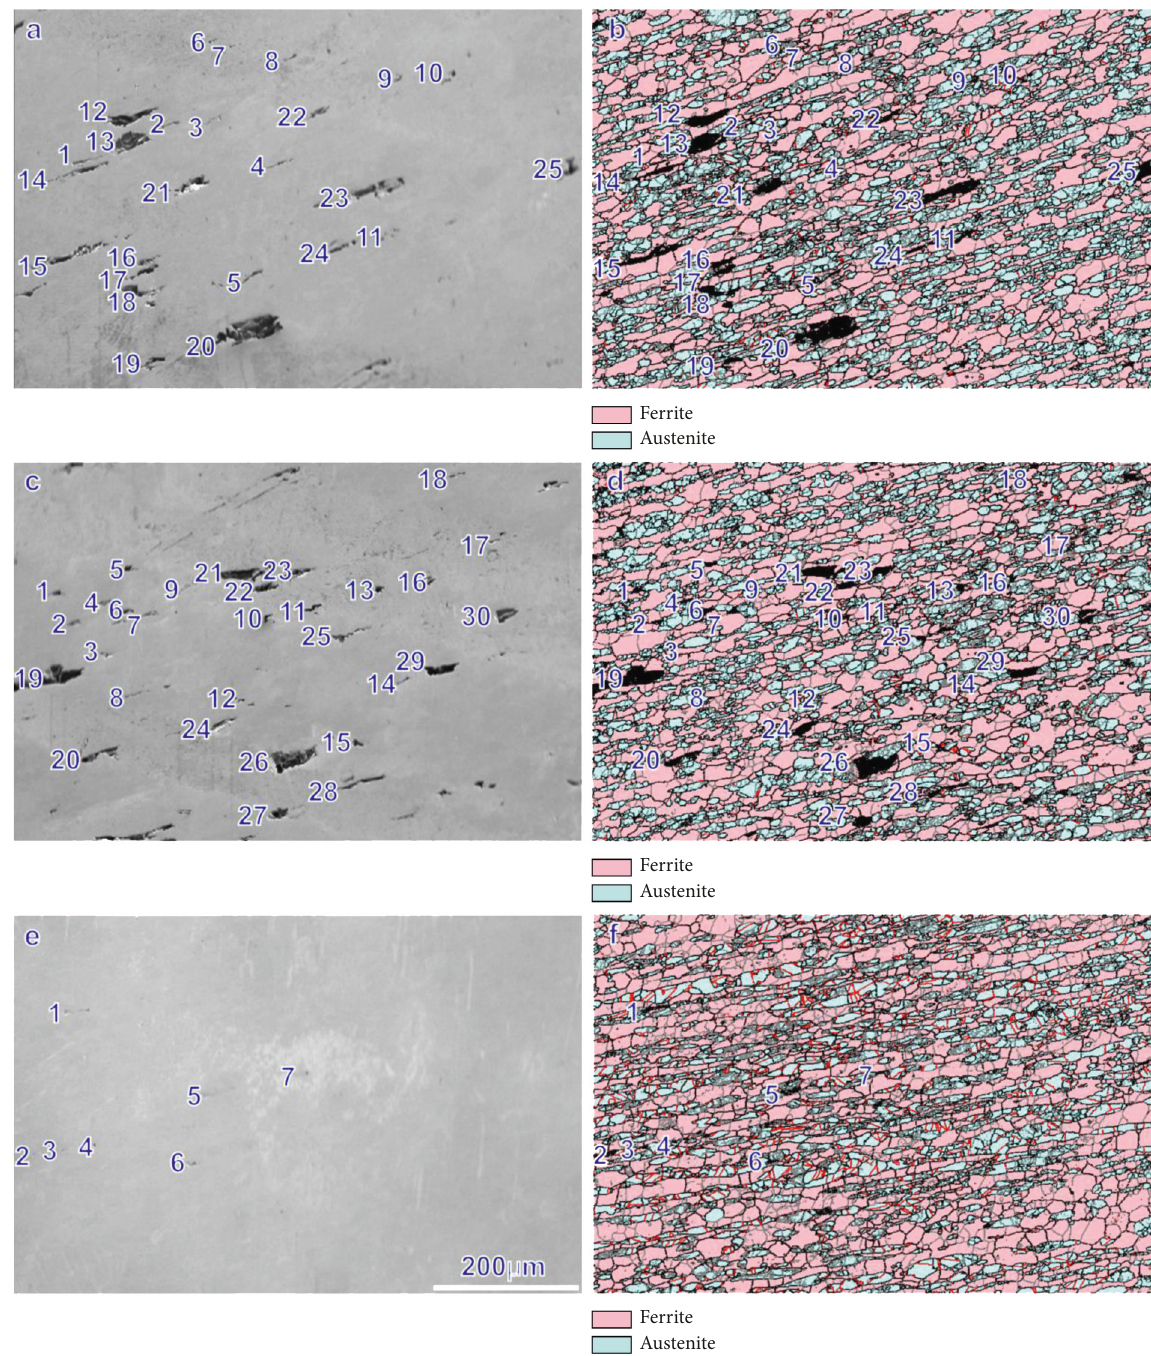
Figure 4: Microstructure of specimens strained at different strain rates to 0.4. (a, b) 0.005s –1 ; (c, d) 0.05 s –1 ; (e, f) 0.5 s –1 . (a), (c), and (e) are SEM images, and (b), (d), and (f) are corresponding phase maps. The horizontal direction is the tensile